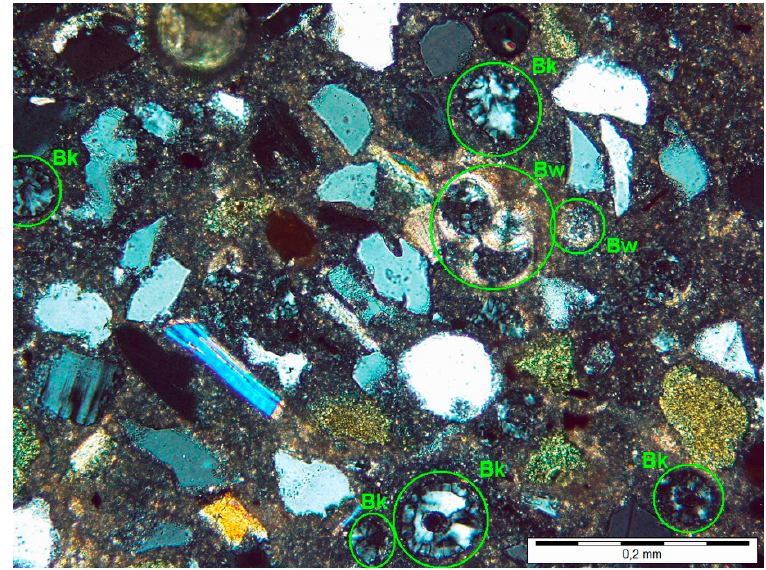
Figure 1. Texture of quartz-glaukonitic sandstone with clay-carbonate cement at 120× magnification. Marked silicate (Bk) and carbonate (Bw) bioclasts.